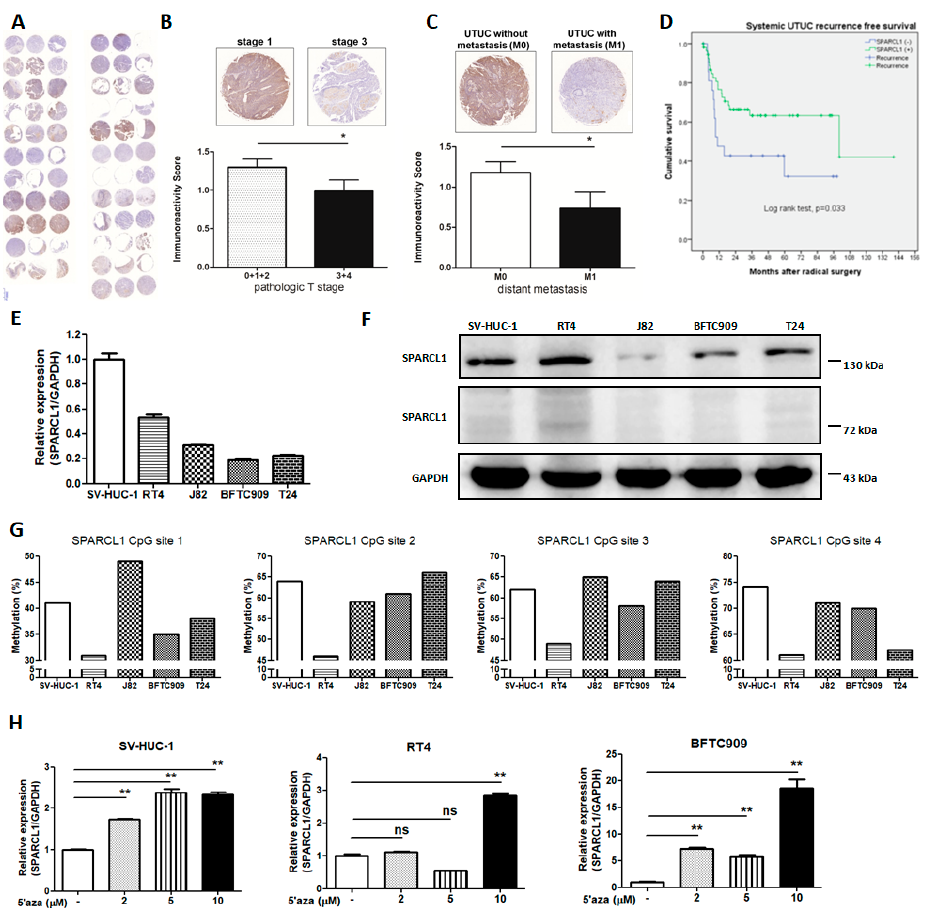
Figure 3. SPARCL1 was down-regulated in aggressive UTUC via DNA methylation. ( A ) The IHC staining of SPARCL1 in human UTUC TMA samples with triplicate cores per case. ( B ) A significantly reduced expression of SPARCL1 in UTUC with pathologic tumor stages 3 and 4 compared to those with stages 0, 1, and 2 was determined by IHC staining. * p < 0.05 between the indicated groups. ( C ) Immunoreactivity score of SPARCL1 protein expression in M0 and M1 tumor of human UTUC. * p < 0.05 between the indicated groups. ( D ) Significantly worse systemic UTUC recurrence free survival in SPARCL1 negative UTUCs. ( E ) RT-qPCR and ( F ) Western blots of SPARCL1 expression in an immortalized human urothelial cells (SV-HUC-1), a low grade urothelial carcinoma cell line (RT4) and 3 high grade urothelial carcinoma cell lines (J82, BFTC909, and T24). β -actin was used as a loading control. The predicted molecular weight of SPARCL1 is ~75kDa and we did not detect SPARCL1 monomer bands (~75 kD). SPARCL1 molecular weight was approximately 150 kDa, suggesting that it may be present in the homodimer form. ( G ) SPARCL1 CpG site methylation levels in UC cell lines. ( H ) The mRNA expression of SPARCL1 was detected by RT qPCR in SV-HUC-1, RT4 and BFTC909 cell lines treated with 5-aza-2 (cid:48) -deoxycytidine. Error bars represent the mean ± S.E.M., ** p < 0.01; ns indicates no